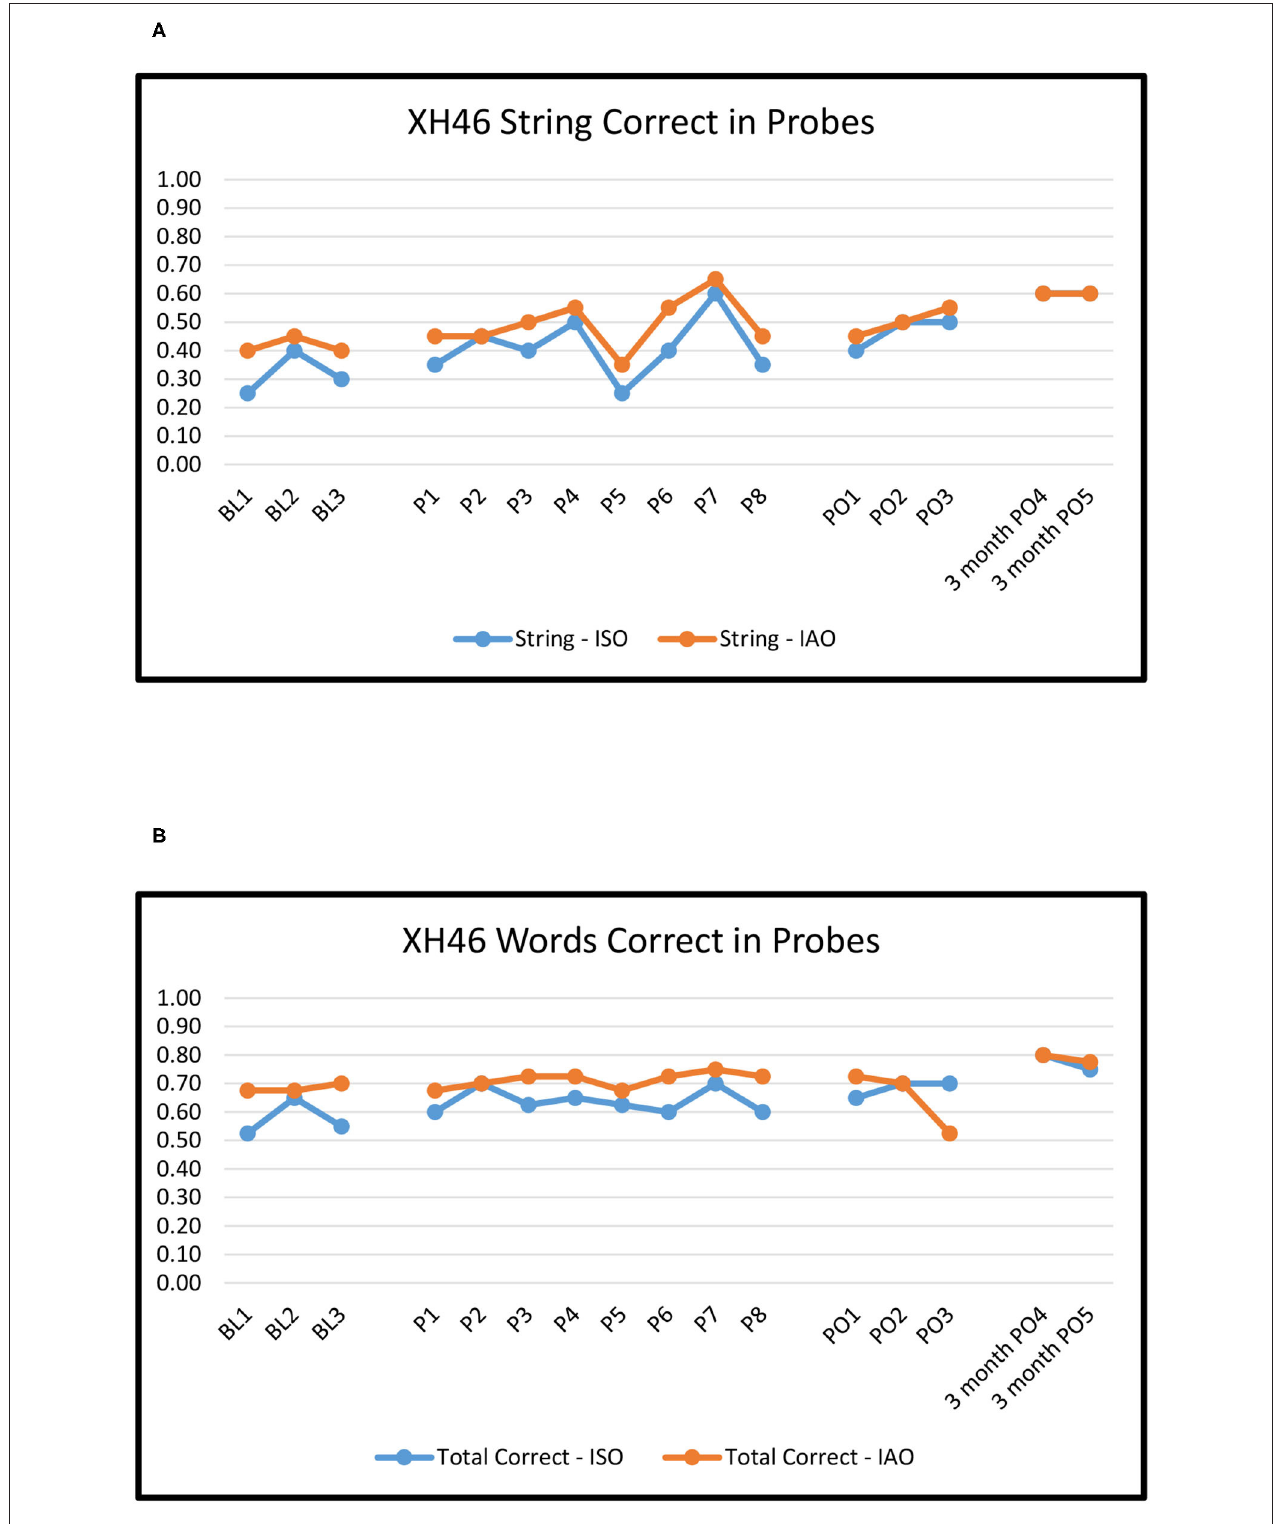
FIGURE 6 | KK55: Proportion of word strings (A) and words (B) correct in baseline, treatment, post-treatment, and 3 months follow-up probes.